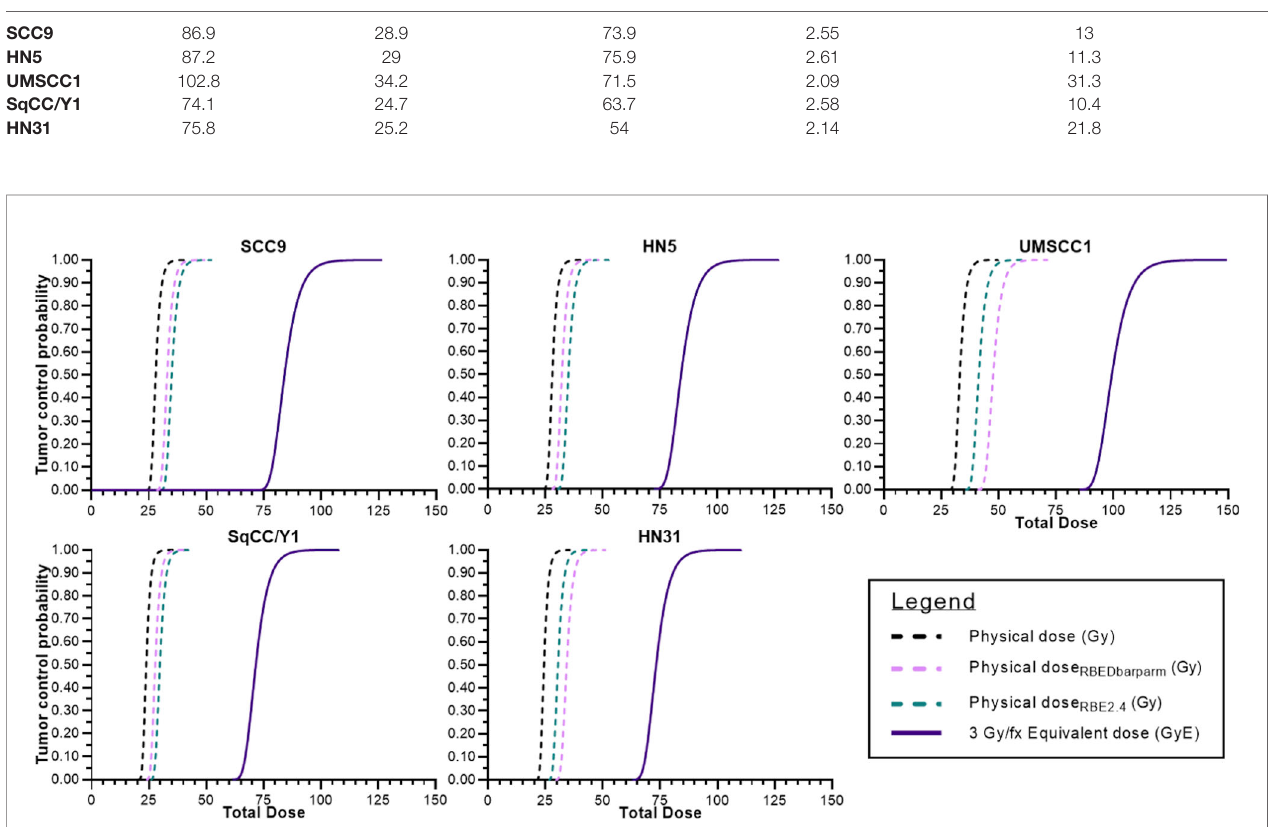
TABLE 3 | Comparisons of GyE based upon use of a fi xed RBE vs. the actual RBE for a given cell line and the dose differential for a tumor control probability of 70%. Cell line